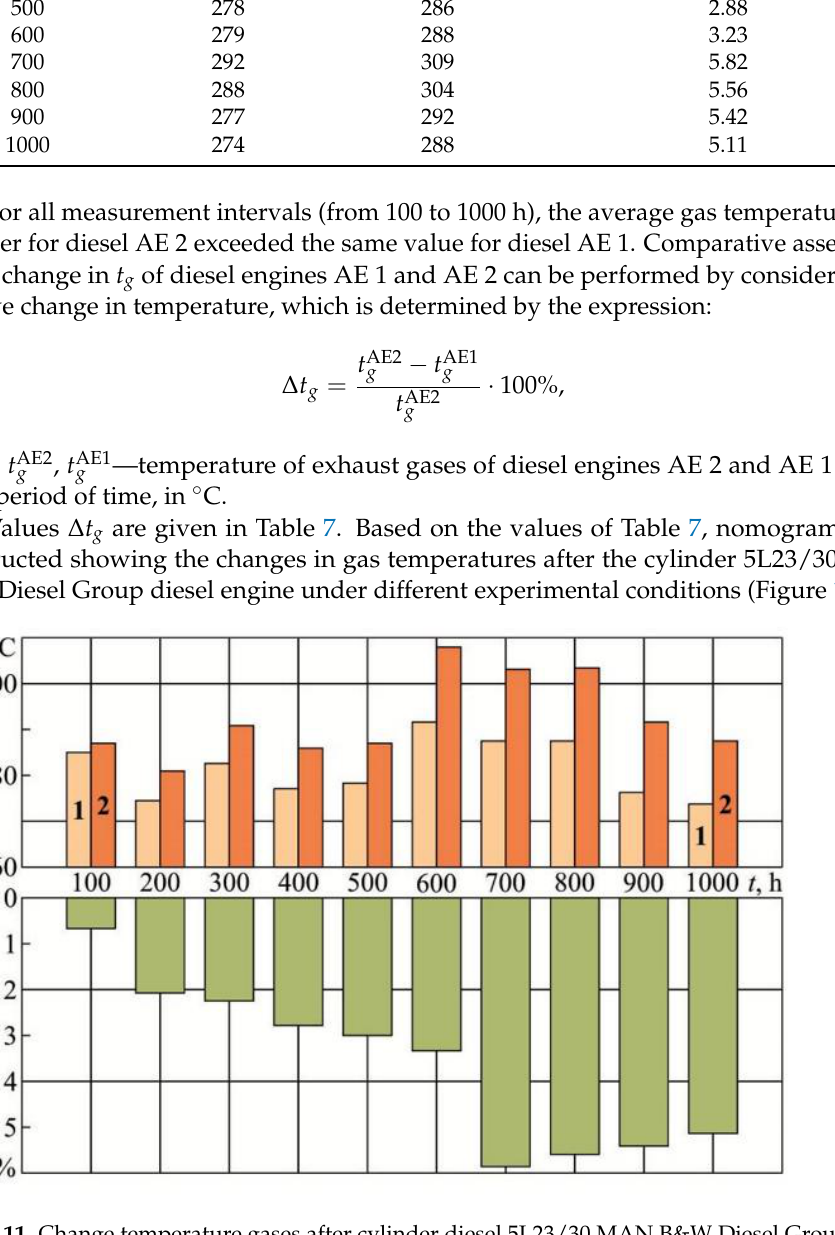
Figure 11. Change temperature gases after cylinder diesel 5L23/30 MAN B&W Diesel Group under different experimental conditions: 1 — diesel AE 1; 2 — diesel AE 2.